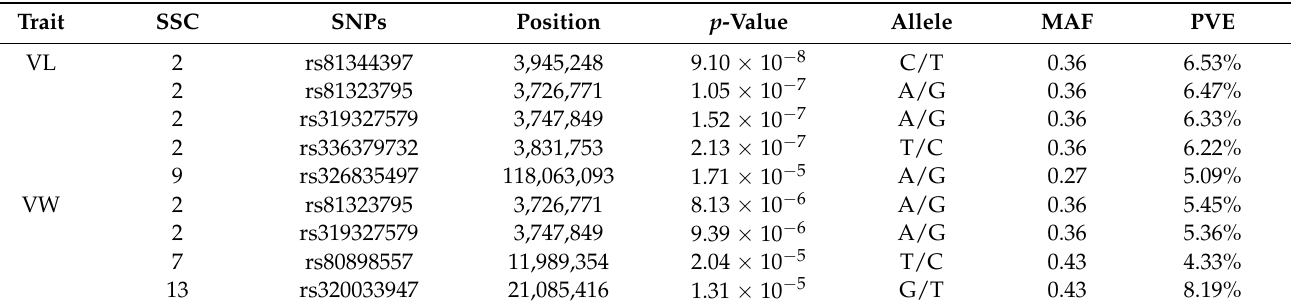
Table 3. Significant SNPs for three vulvar traits of Suhuai pigs by Chip data.